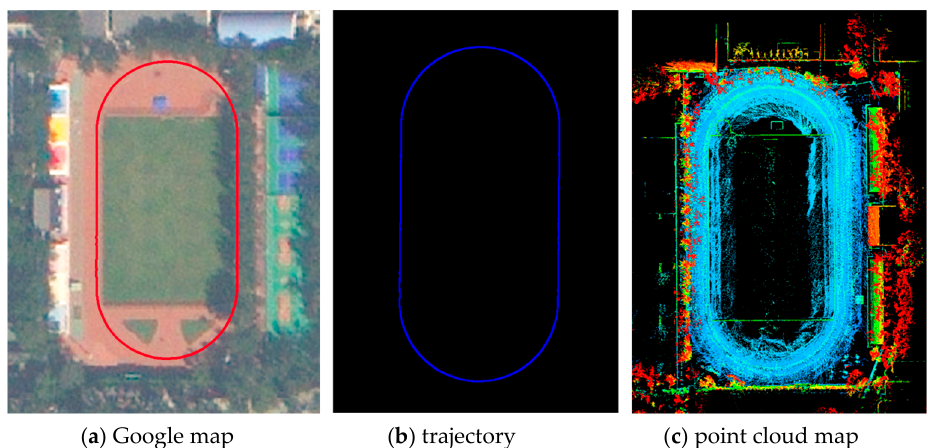
Figure 6. Playground experimental data map: ( a ) the Google map; ( b ) the trajectory recovered by Inertial Explorer; and ( c ) the point cloud map reconstructed by ( b ).